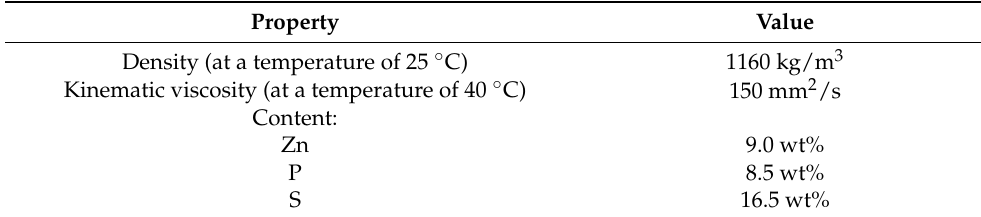
Table 3. The basic properties of zinc dialkyldithiophosphate (ZDDP). Property